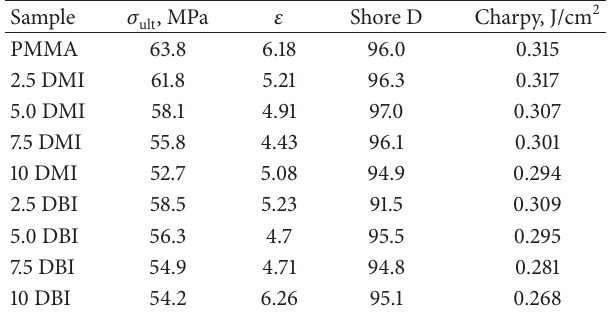
Table 3: Ultimate tensile strength ( 𝜎 Shore D hardness, and Charpy impact strength of PMMA denture base materials modified with DMI and